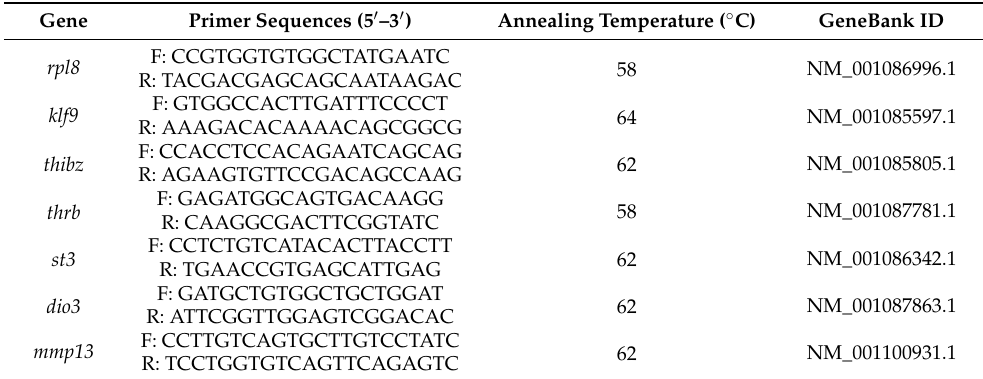
Table 1. Primer sequences of all tested Xenopus laevis genes and conditions for quantitative polymerase chain reaction